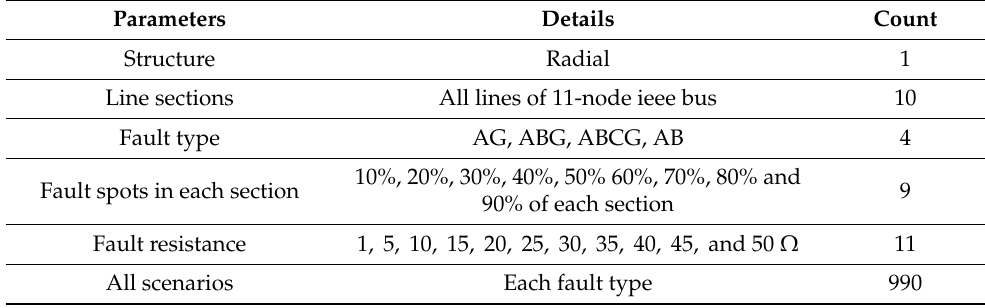
Figure 7. Frequency spectrum of two sample faults in Sections 5 and 6. Table 2. The simulation parameters details.